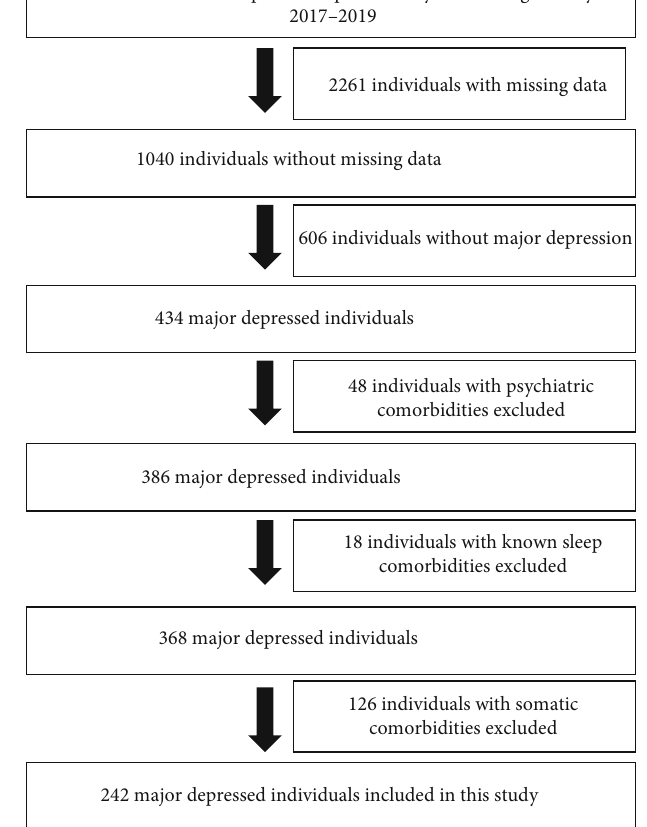
Figure 1: Selection diagram of major depressed individuals included in this